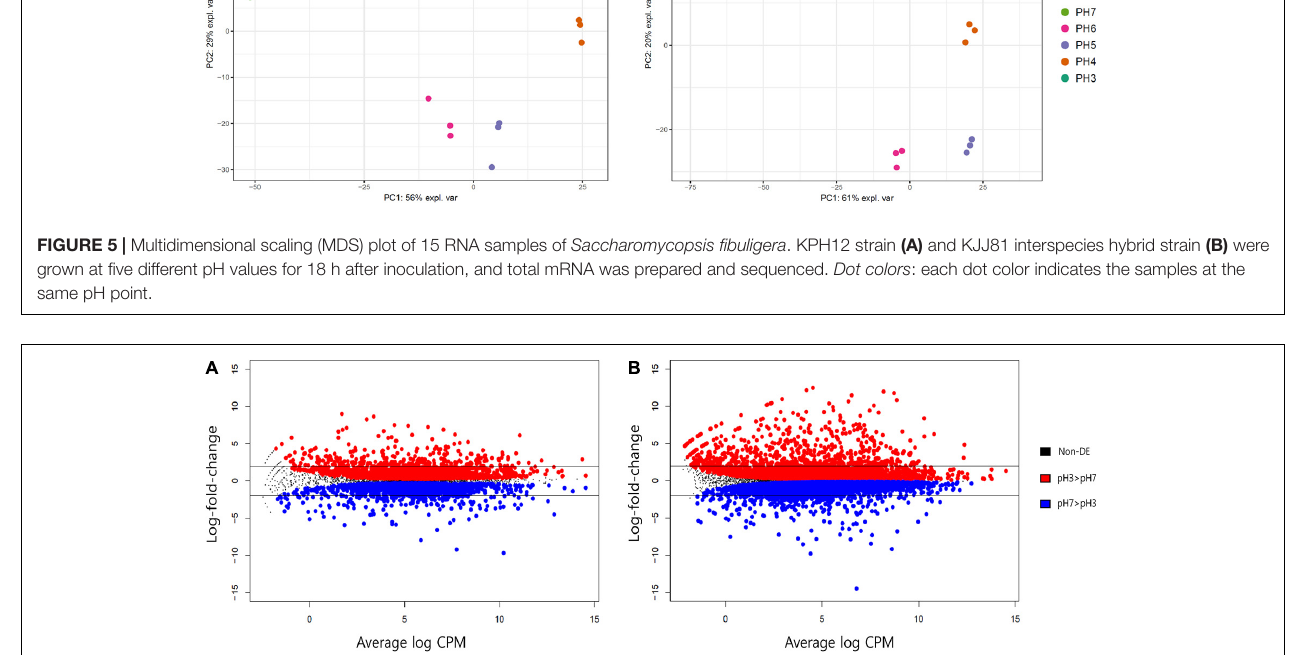
FIGURE 6 | MD plot analysis for the average expression level of all genes of Saccharomycopsis fibuligera . KPH12 strain (A) and KJJ81 interspecies hybrid strain (B) at pH 3 and the log 2 fold-change of each gene from pH 3 to pH 7. Blue : genes with a significant decrease in expression at an FDR of 5%; and red : genes with a significant increase in expression at an FDR of 5%. Non-significant genes are in black. Horizontal black bars indicate genes that exhibited at least a fourfold change in expression (log 2 FC =